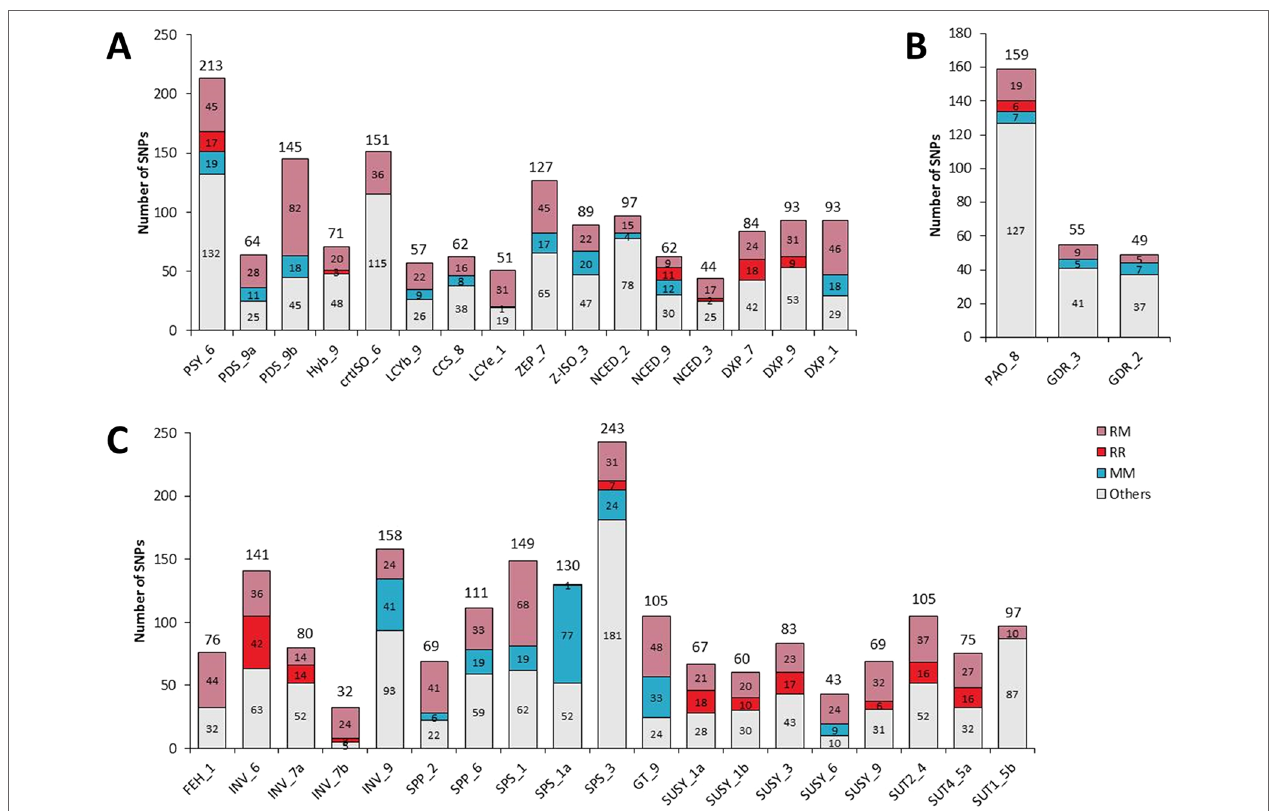
FIGURE 3 | Classification of SNPs. (A) Genes related to the carotenoid metabolic pathway. (B) Genes related to the sugar metabolic pathway. (C) Genes related to the chlorophyll metabolism. RM indicates SNPs segregating C. reticulata from C. maxima (interspecific segregation). RR indicates SNPs allowing intraspecific segregation of C. reticulata. MM indicates SNPs allowing intraspecific segregation of C. maxima. The Others category corresponds to SNPs that allowed segregation different from RM, RR, or MM. The total number of SNPs is indicated at the top of each